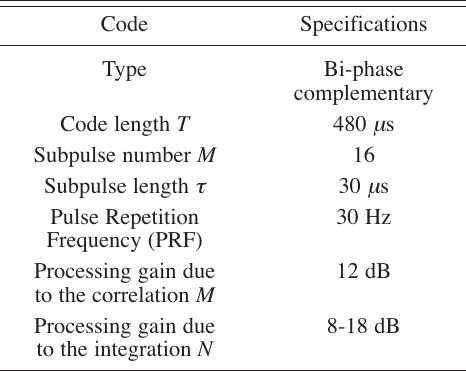
Fig. 2. Correlation results for code 1, code 2 and their addition. On x axis distance of an echo in km is indicated, while on y axes an arbitrary scale is used. Table I. Processing and phase code